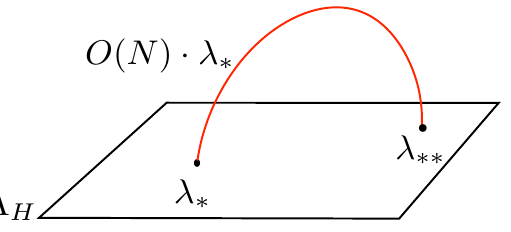
Figure 3: If the orbit O ( N ) · λ ∗ has any other intersections with Λ as in this figure, the fixed point λ ∗ cannot be RG-stable within Λ